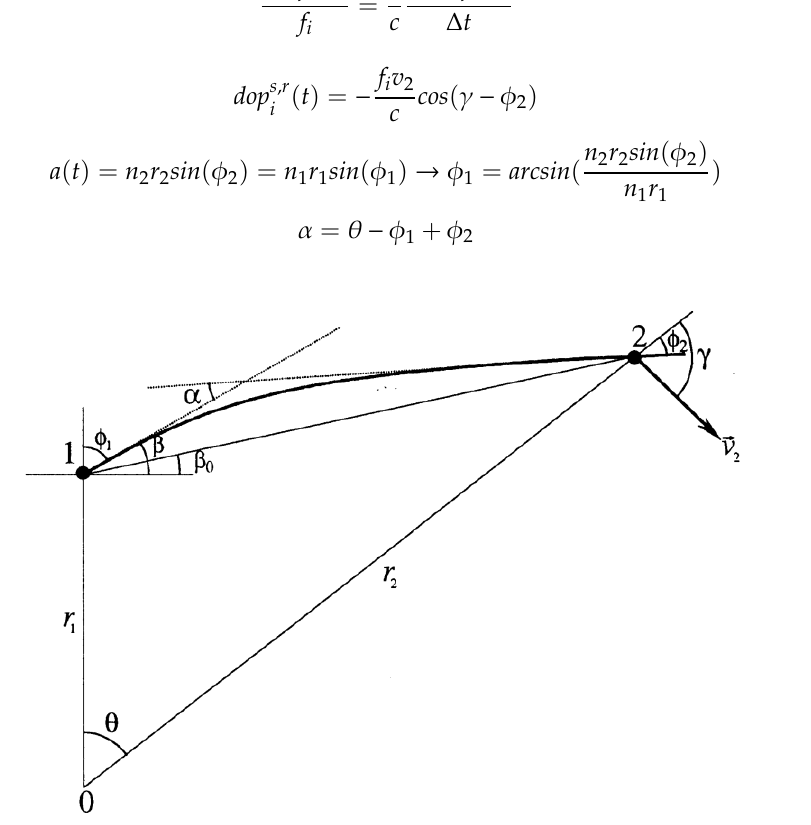
Figure 2. Geometry diagram of mountain base occultation. Coordinate point 1 represents the site of the mountain base test, at the top of Wuling Mountain. Coordinate point 2 represents the navigation satellite at an occultation